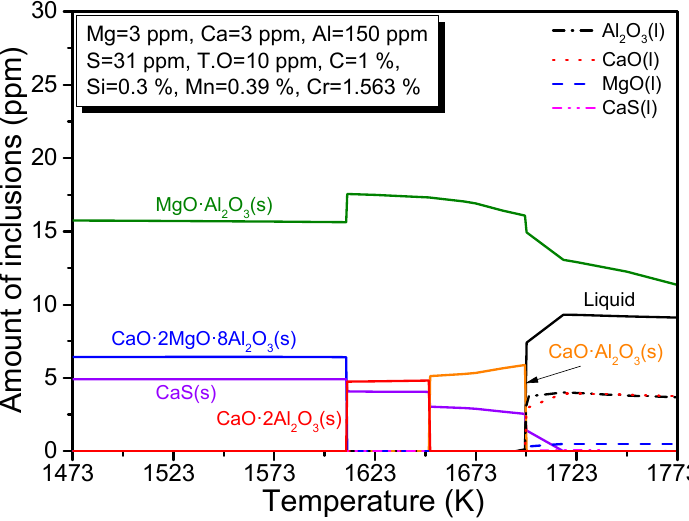
Figure 20. The comprehensive transformation of inclusions in bearing steels at various temperature considering the steel with 10 ppm T.O.